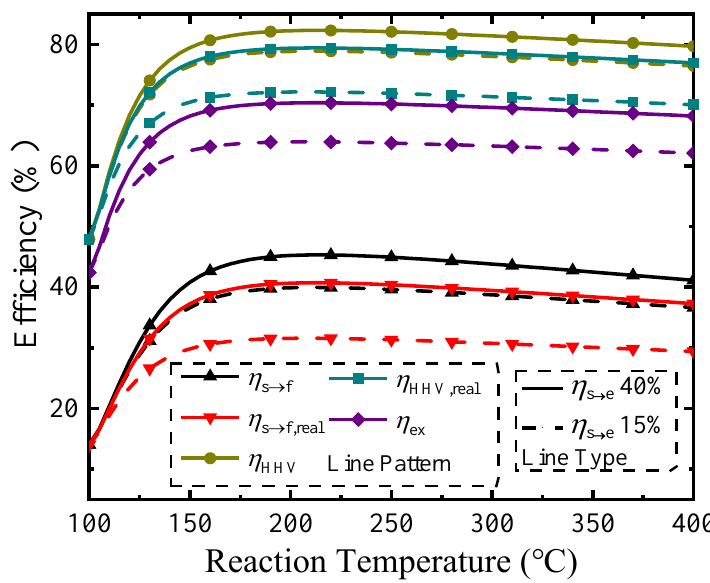
Figure 5. Thermodynamic efficiency versus temperature for a permeate pressure of 0.2 bar.